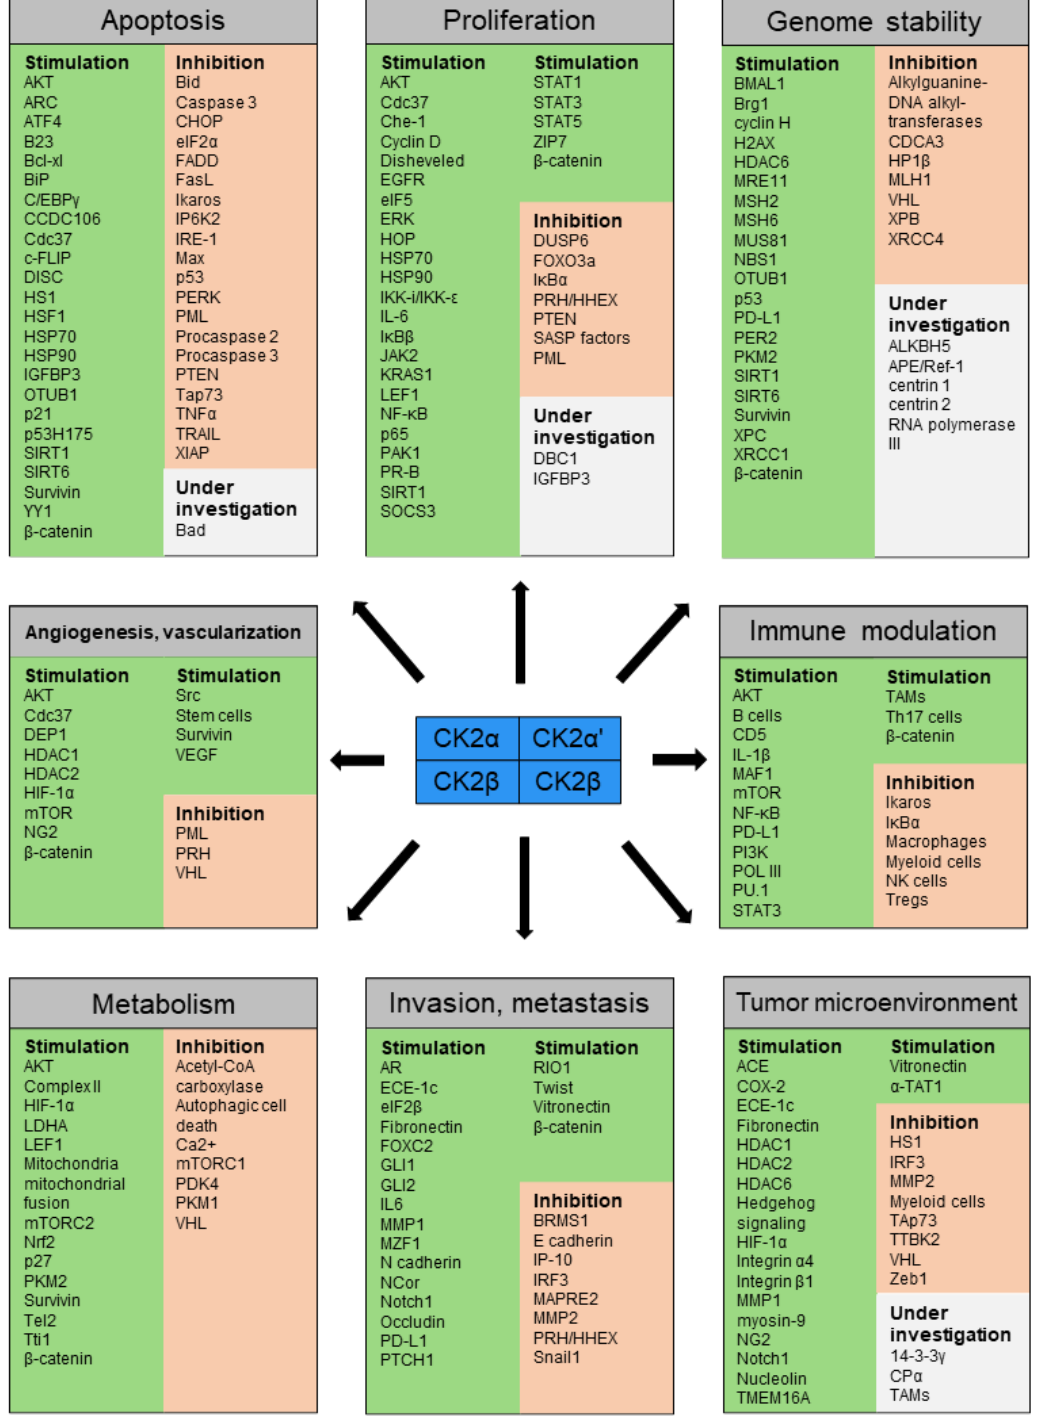
Figure 9. CK2-dependent stimulation or inhibition of several proteins is responsible for cancer progression. Shown are all cancer-associated proteins, which are phosphorylated by CK2 and men- tioned in this review. Listed in the areas highlighted in red are proteins, which are functionally stimulated by this phosphorylation, listed in the areas highlighted in green, are proteins, which are functionally reduced by Ck2-dependent phosphorylation. Proteins where the effect of phosphoryla- tion on the functionality of the protein is not yet known are highlighted in light gray.